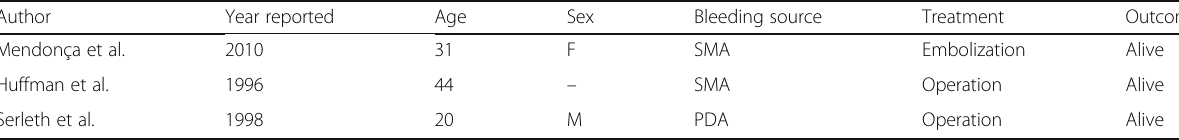
Table 1 Three cases of the rupture of SMA and PDA